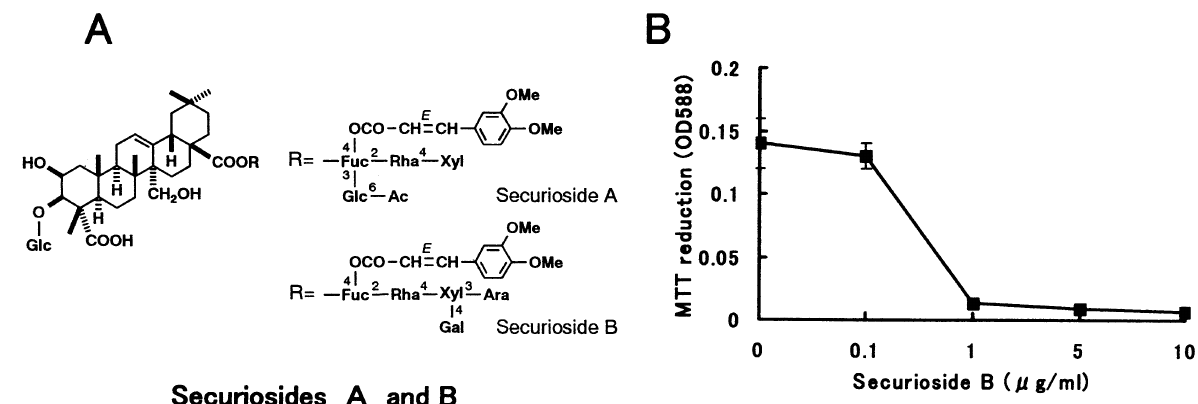
FIG. 1. (A) Structure of securiosides A and B. (B) Dose (cid:1) / response relationship of the cytotoxic effect of securioside B against the BAC1.2F5 cells. The BAC1.2F5 cells were cultured with 20% L-cell-conditioned medium and the indicated concentrations of securioside B. MTT-reducing activity was measured on day 3. Bars represent the standard